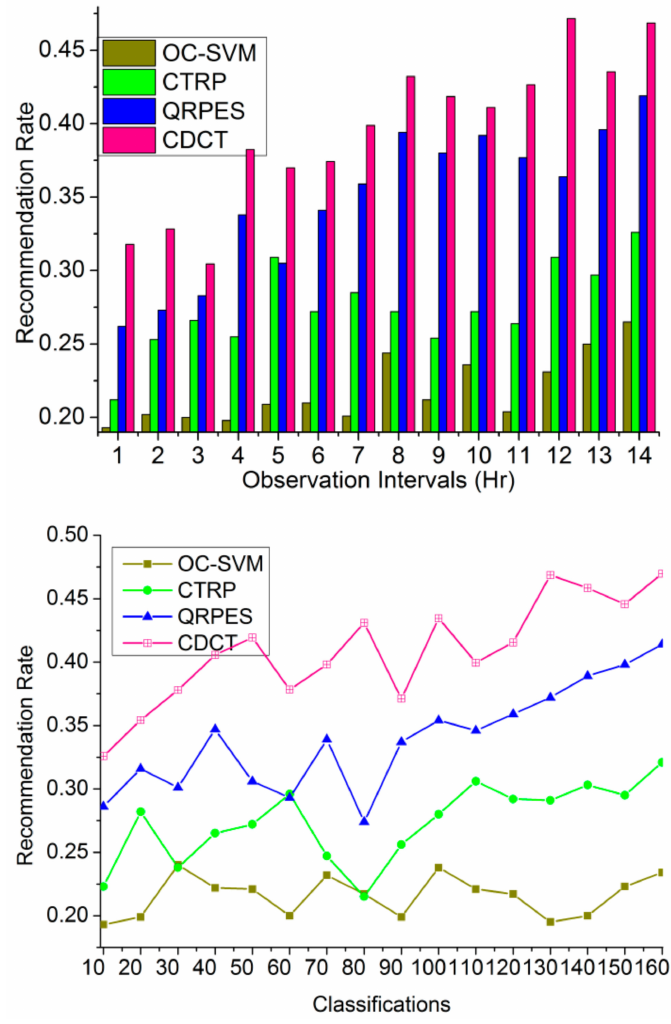
Figure 11. Recommendation Rate for Gas and Emission